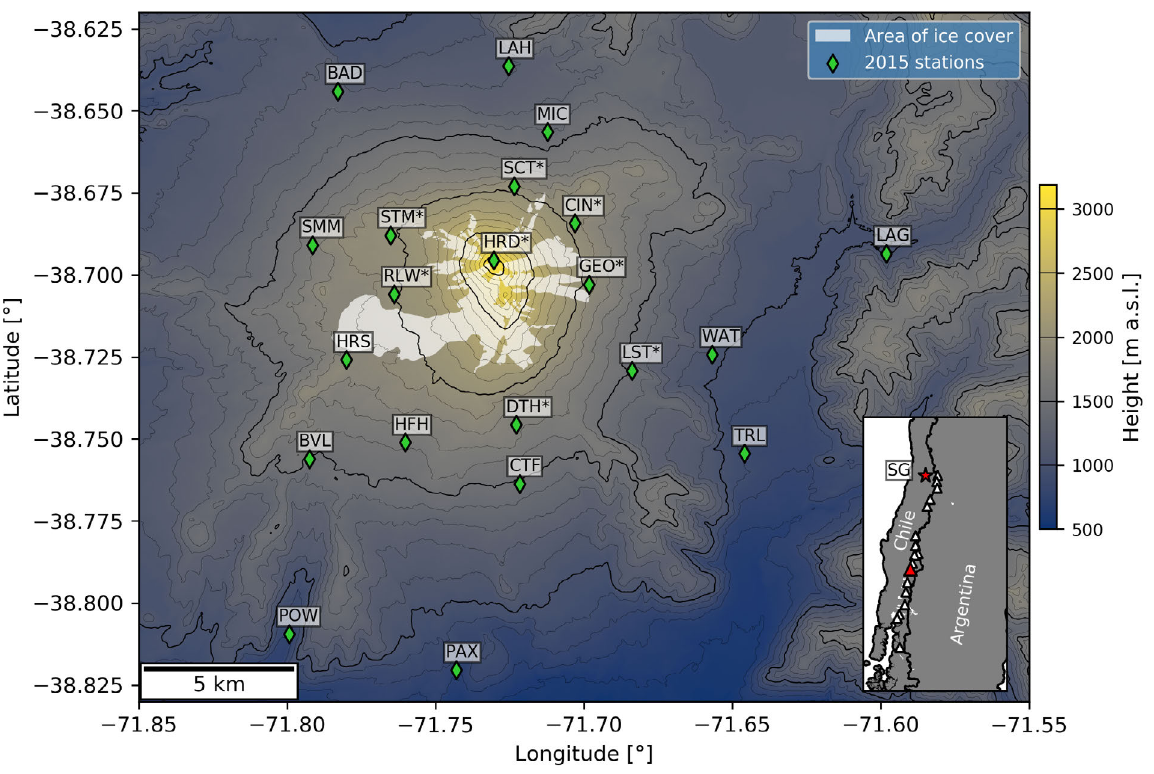
Figure 1: Map of Llaima volcano with the locations of the 2015 seismic stations used in this study marked with green diamonds (5 of the 26 stations are not visible). Names marked with asterisks (*) were those used in the STA/LTA method described in Section section 3. Also marked are the mapped summit glacial areas marked as ‘clear’ or ‘debris-covered’ ice (white area). Thick and thin contours mark 500 and 100 m altitude intervals, respectively. Inset: Map of Southern Chile with the location of Llaima volcano (red triangle) and Santiago (red star, SG) marked. Also plotted are the locations of other ice-covered volcanoes within the Southern Volcanic Zone of Chile that have displayed eruptive activity in last 200 years [white triangles; Venzke 2013].